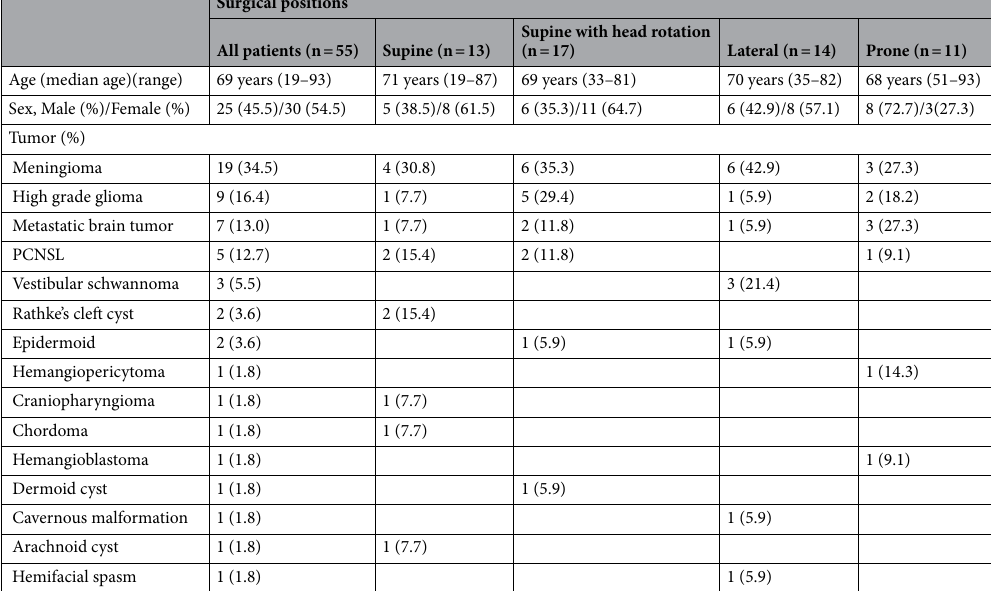
Table 1. Patient characteristics. PCNSL Primary central nervous system